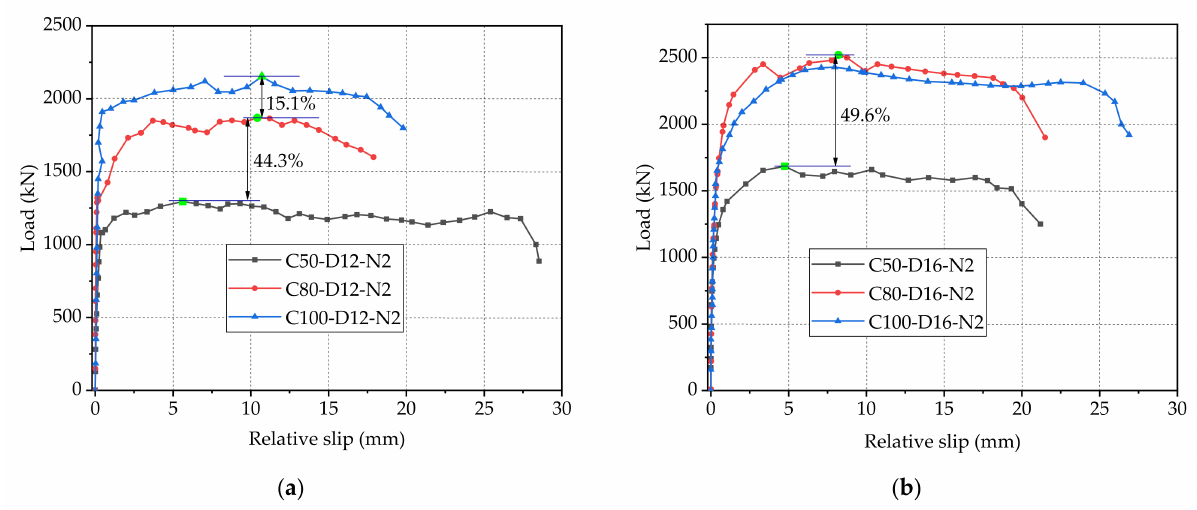
Figure 7. Load-slip curves of specimens with different concrete strength: ( a ) 12-mm-diameter rebar and 2-hole steel plate; ( b ) 16-mm-diameter rebar and 2-hole steel